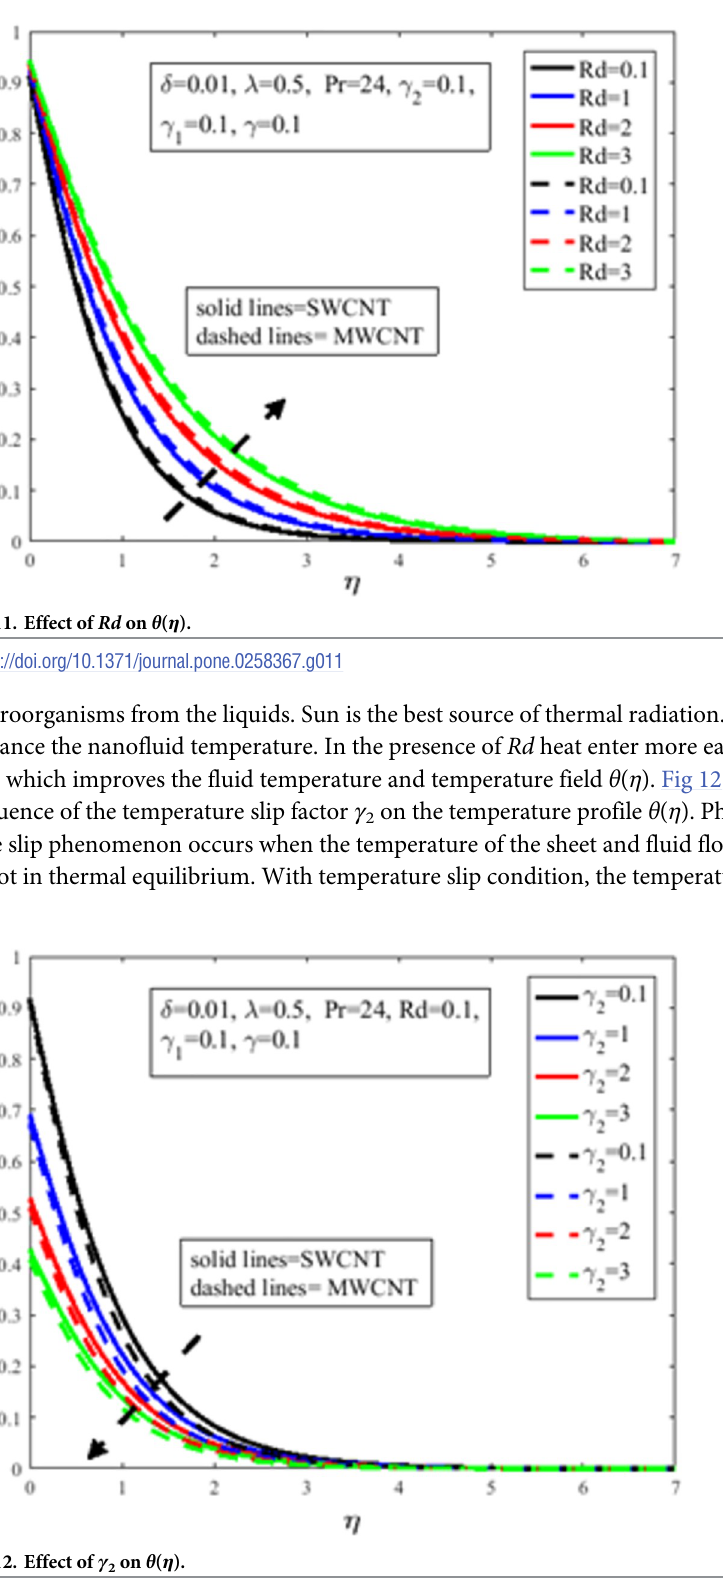
Fig 12. Effect of γ 2 on θ ( η